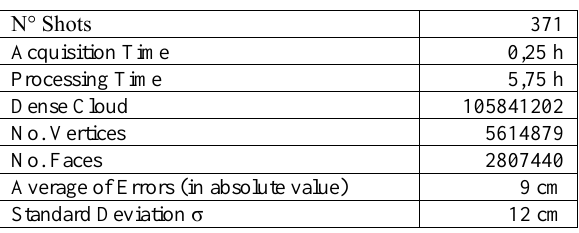
Table 1. Summary of results obtained by drone